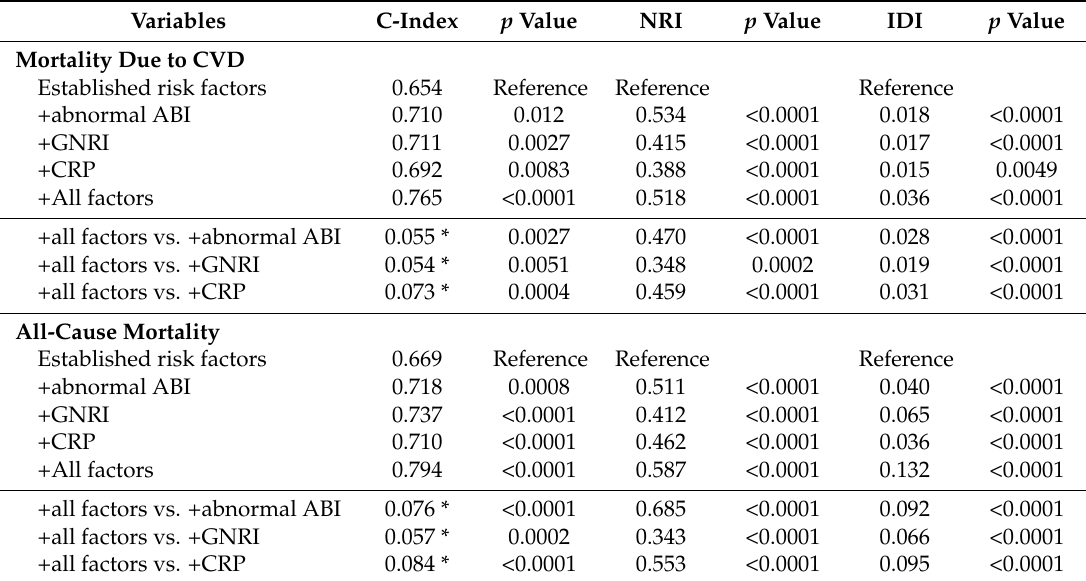
Table 6. Discrimination of each predicting models for mortality using C-index, net reclassification improvement (NRI), and integrated discrimination improvement